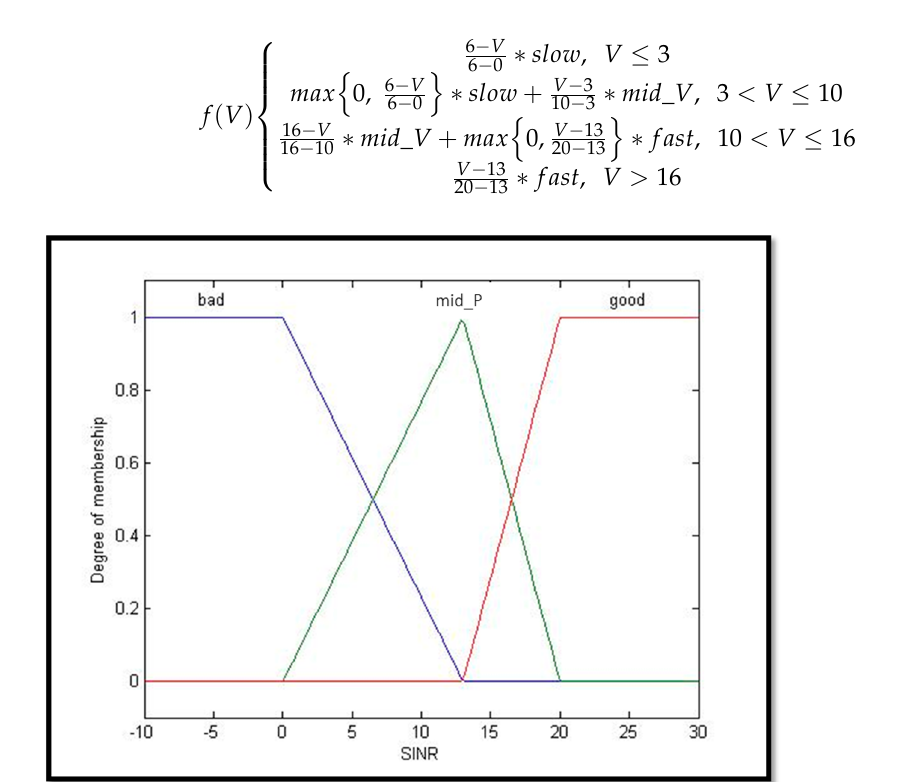
Figure 6. Membership function of SINR.